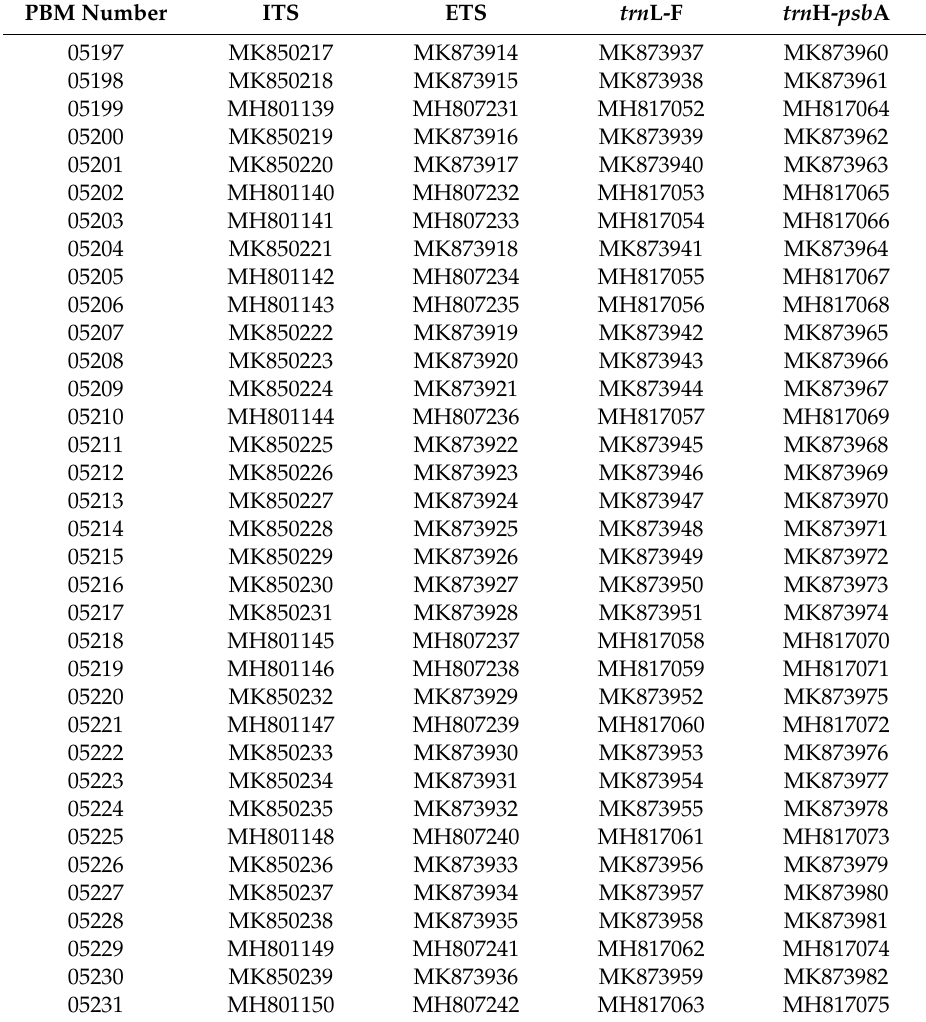
Table 4. Accession number of the sequences deposited in NCBI GenBank